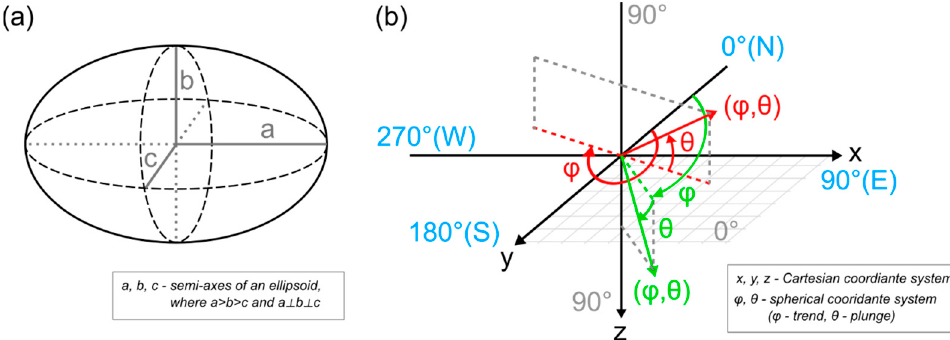
Figure A1. ( a ) An ellipsoid and dependency between its semi-axes; ( b ) The rule of coordinates transformation from the Cartesian coordinate system in Fiji software to the spherical coordinate system of vectors representing semi-axes of the ellipsoids. Table A2. The libraries utilised for data manipulation, visualization and analysis in R.